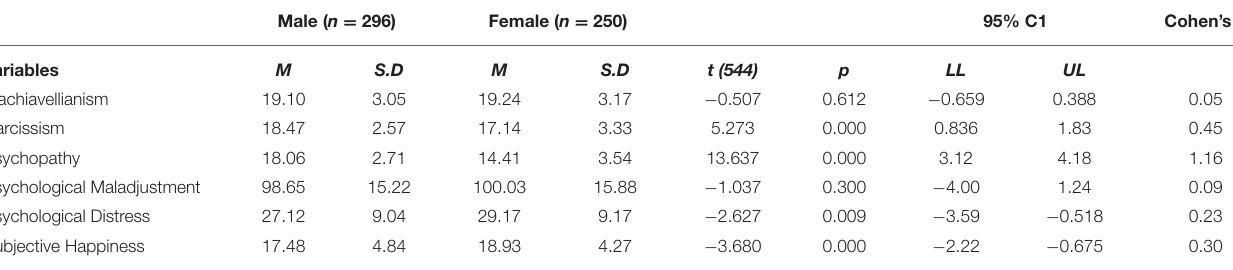
TABLE 2 | Gender differences in study variables ( N = 546).